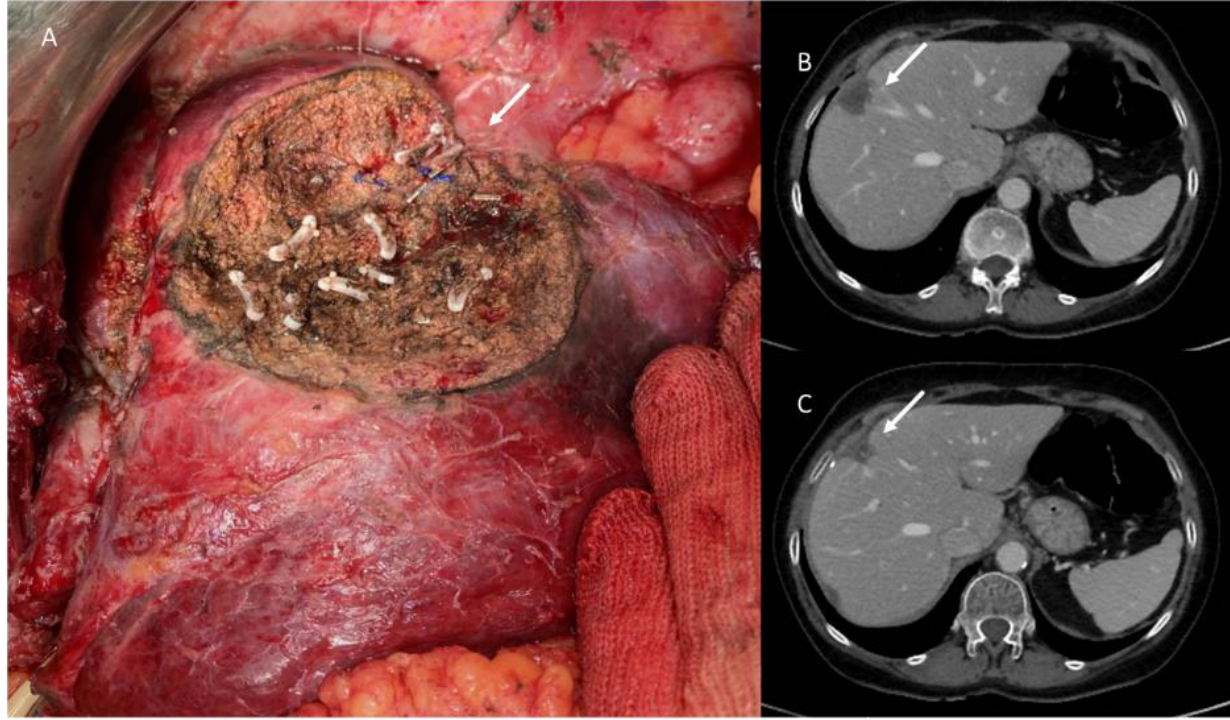
Figure 5. In ( A ), atypical liver resection of lesion located in V-VIII segment in patient with metastases from colorectal cancer. In ( B , C ) CT post treatment evaluation. At discharge, arrow shows fluid collection; at 3 month CT follow-up, arrow shows scar tissue ( C ).